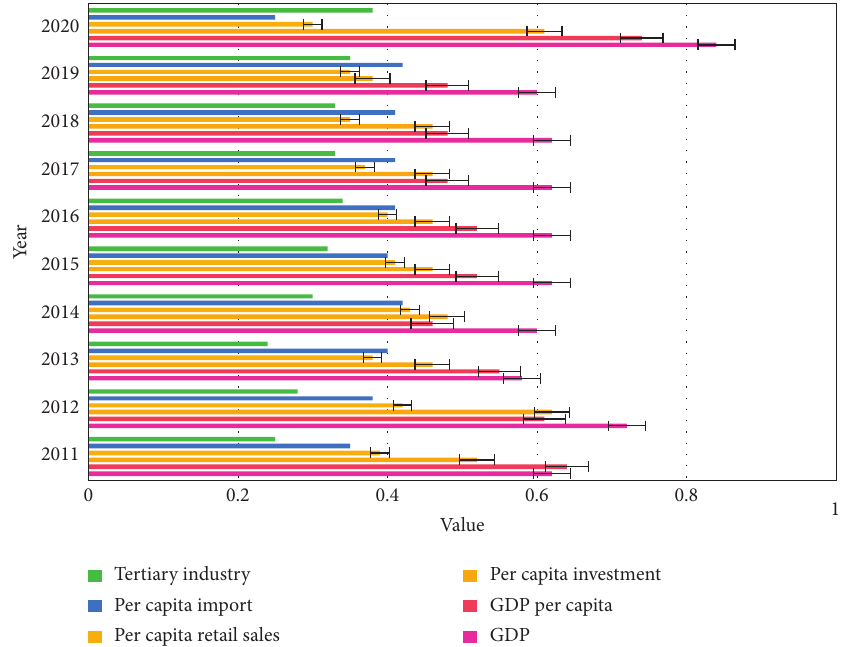
Figure 12: IBk algorithm-based risk assessment system to analyze the